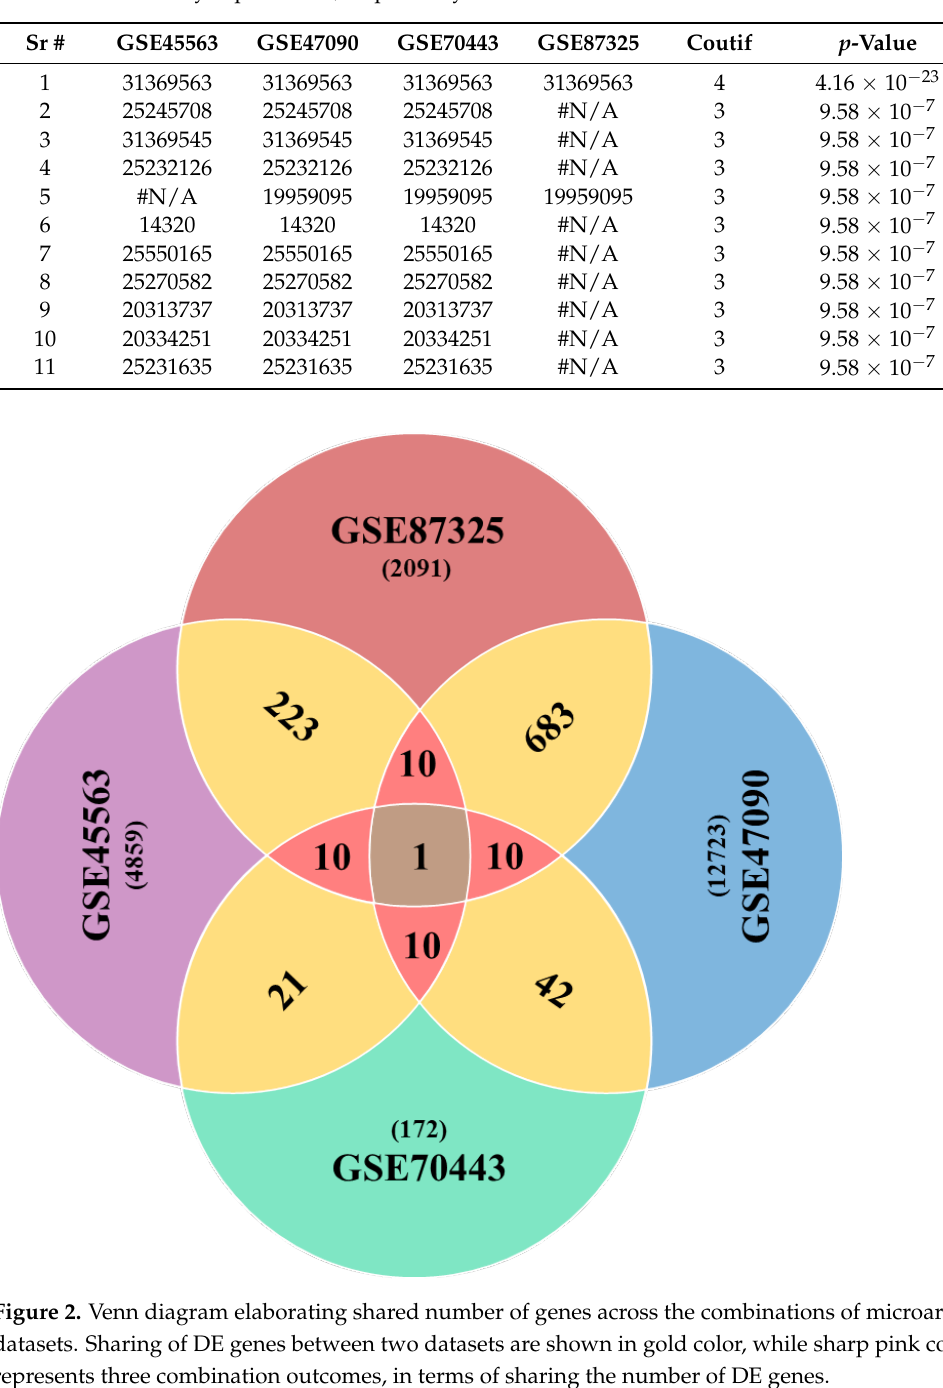
Table 2. Gene ID conversion provided the information about SDGs in the form of columns. First and second columns are the IDs that resulted from differential expression analyses. Similarly, third column was filled with their respective IWGSC IDs due to their high numbers in the form of alignment scores and residual identity in percentages with low E-values. Genomic locations were recorded by searching ENSEMBL database and provided as last three columns. Genes